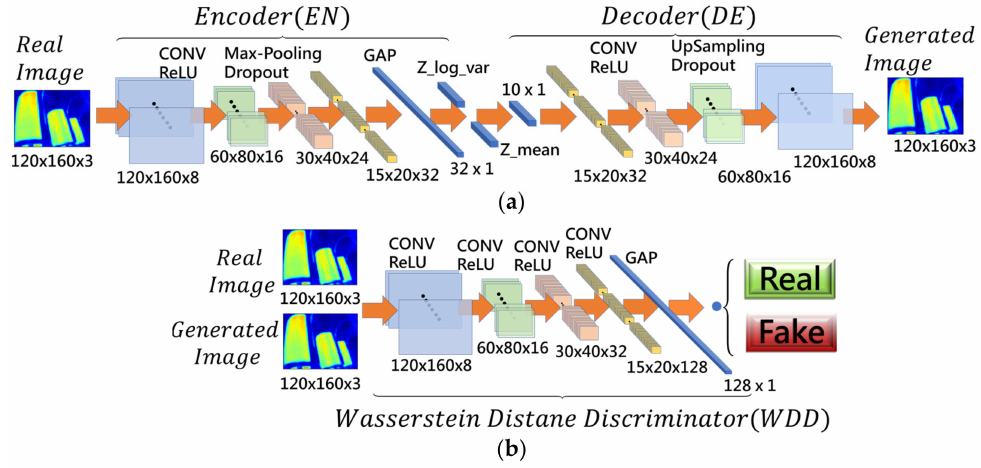
Figure 2. The detailed structure of the proposed VAGWDD model. ( a ) Variational Autoencoder Generator (VAG) networks; ( b ) Wasserstein Distance Discriminator (WDD)